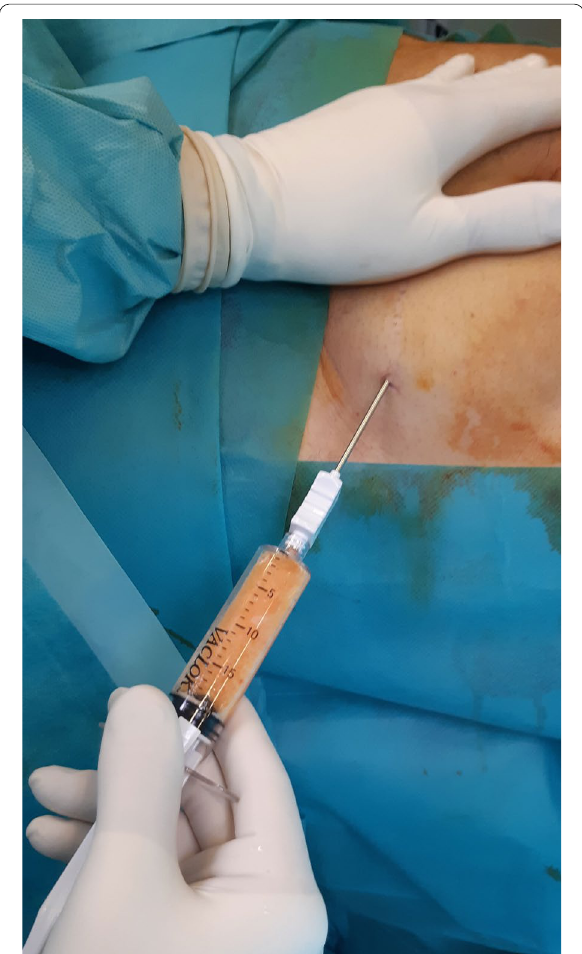
Fig. 2 A standard percutaneous lipoaspiration is performed at least 10 min after the infiltration of the solution with ropivacaine and adrenaline; in this study, the lipoaspiration was always performed after the knee